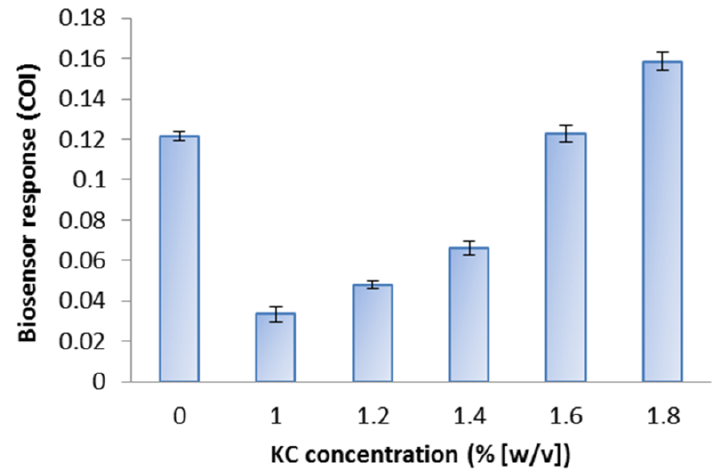
Figure 2. Responses of E. coli roGFP2 oxidative stress biosensors embed in several concentrations of KC. The cell density of E. coli roGFP2 was fixed at 4.5 × 10 8 cfu·mL −1